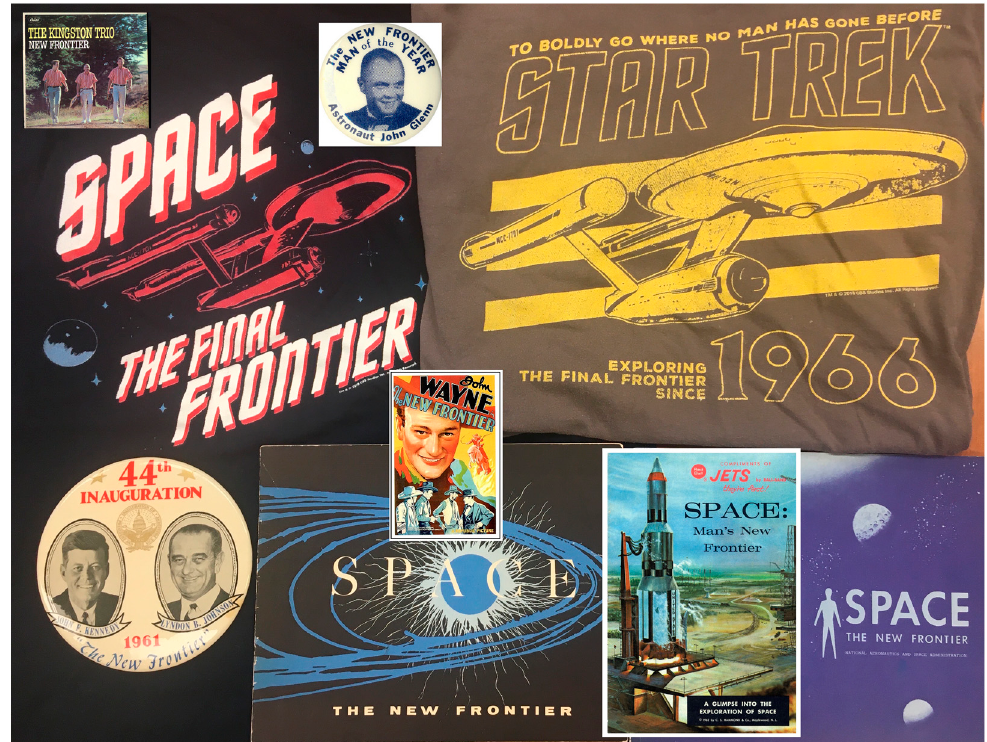
Figure 1. Usage of the term “New Frontier” was not new, having been used to sell movies on the big screen such as the 1935 Western The New Frontier starring John Wayne. However, during the decade of the sixties, it increased in popularity due, in large part, to its adoption by John F. Kennedy as the theme for his successful 1960 presidential campaign. The term stuck around after Kennedy became president and continued to be used not only by NASA and its astronauts, but also by the media to promote such things as tennis shoes, record albums, and television shows.